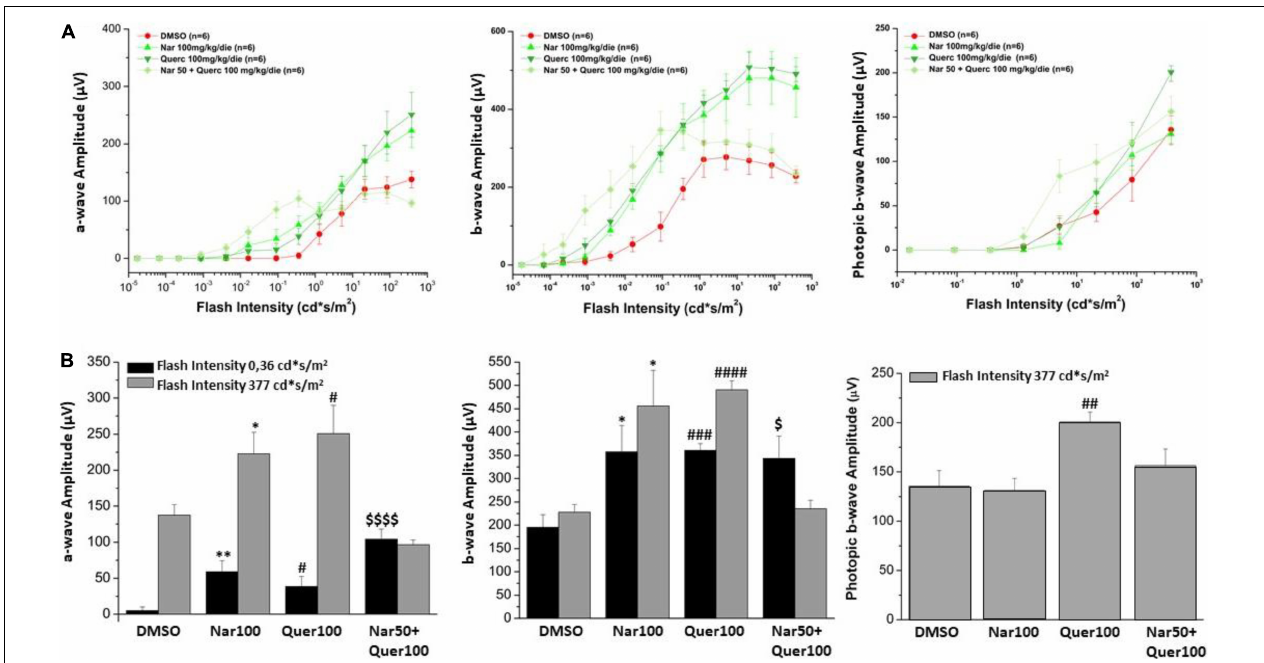
FIGURE 3 | Retinal function was assessed by scotopic and photopic ERG recording. (A) Scotopic a- and b-wave amplitude and photopic b-wave amplitude as a function of light stimulus intensity, in treatment (green scale line) and control groups (red line). (B) Histogram for the amplitude of scotopic a- and b-waves at a low light intensity (0.36 cd ∗ s/m 2 , black bars) and the highest (377 cd ∗ s/m 2 , gray bars); the amplitude of photopic b-wave at the highest light intensity (377 cd ∗ s/m 2 , gray bars). Bars represent mean ± SEM; statistical analysis was performed using one-way ANOVA test followed by Bonferroni test ( ∗ p ≤ 0.05, ∗∗ p ≤ 0.01 naringenin 100 group vs. DMSO group; # p ≤ 0.05, ## p ≤ 0.01, ### p ≤ 0.001, #### p ≤ 0.0001 quercetin 100 group vs. DMSO group; $ p ≤ 0.05, $$$ p ≤ 0.001, naringenin 50 + quercetin 100 group vs. DMSO